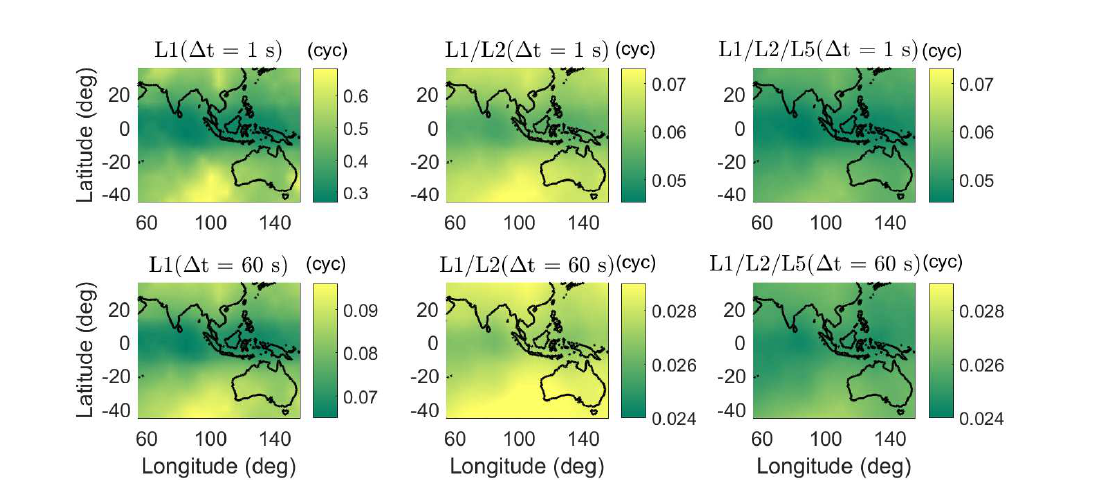
Figure 6. Daily average ADOPs using single-, dual-, and triple-frequency phase signals with ∆ t of 1 (top) and 60 s (bottom). Note that the sub-figures have different